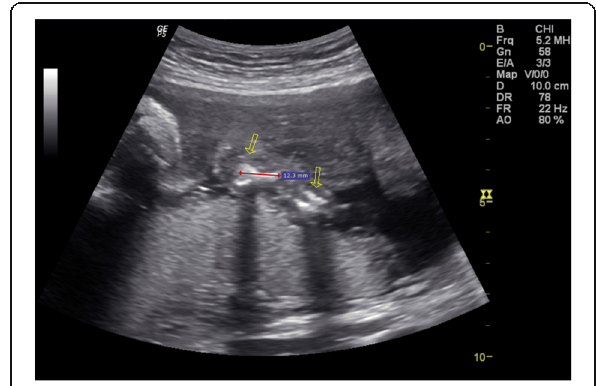
Fig. 3 Axial image of the fetal head at the level of cerebellum shows grossly increased nuchal fold thickness (arrow) appearance of ribs without any fractures, and concavity of inferior and medial borders of ilium which has also been described as “ paraglider appearance ” [6] (Fig. 5). The ossification centers of ischium and pubis were also not visualized. The metaphyses of long bones appeared flared with lateral spurs seen at proximal metaphyses of bilateral humeri and femora. The skull appeared normal in size and mineralization.